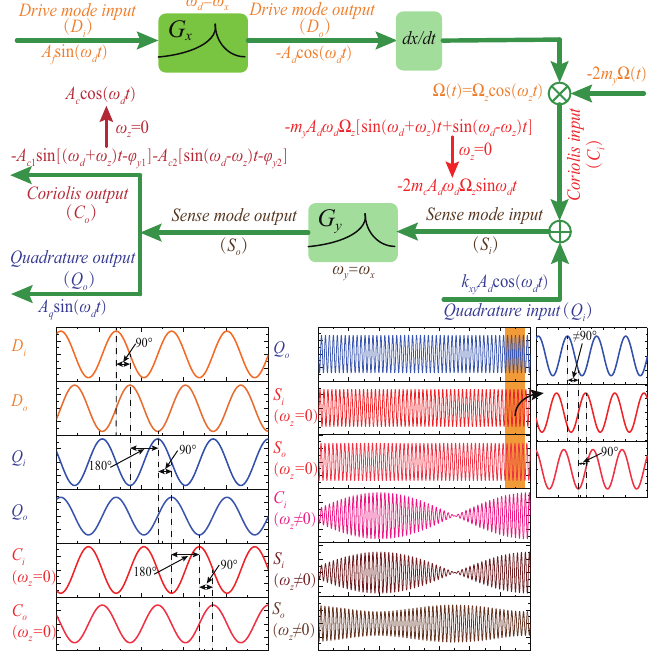
Figure 3. The phase relationship between the drive mode and sense mode